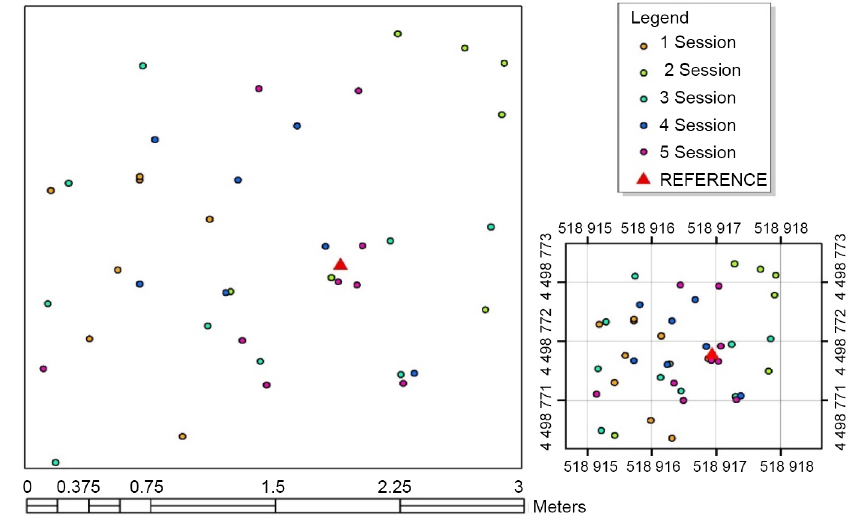
Figure 5. Spatial distribution of the points in different sessions on test site